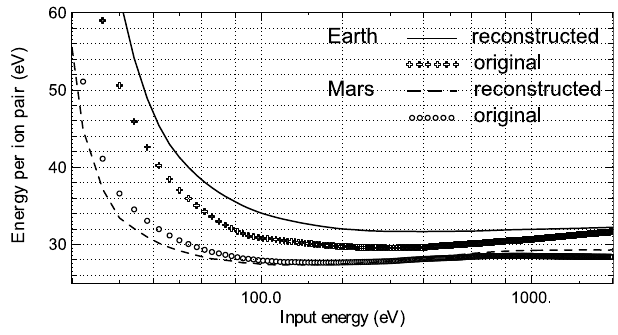
Fig. 5. W net values from the calculation of the whole atmosphere of Earth and Mars (lines) as compared to the reconstructed atmo- spheres from a linear combination of the single species W